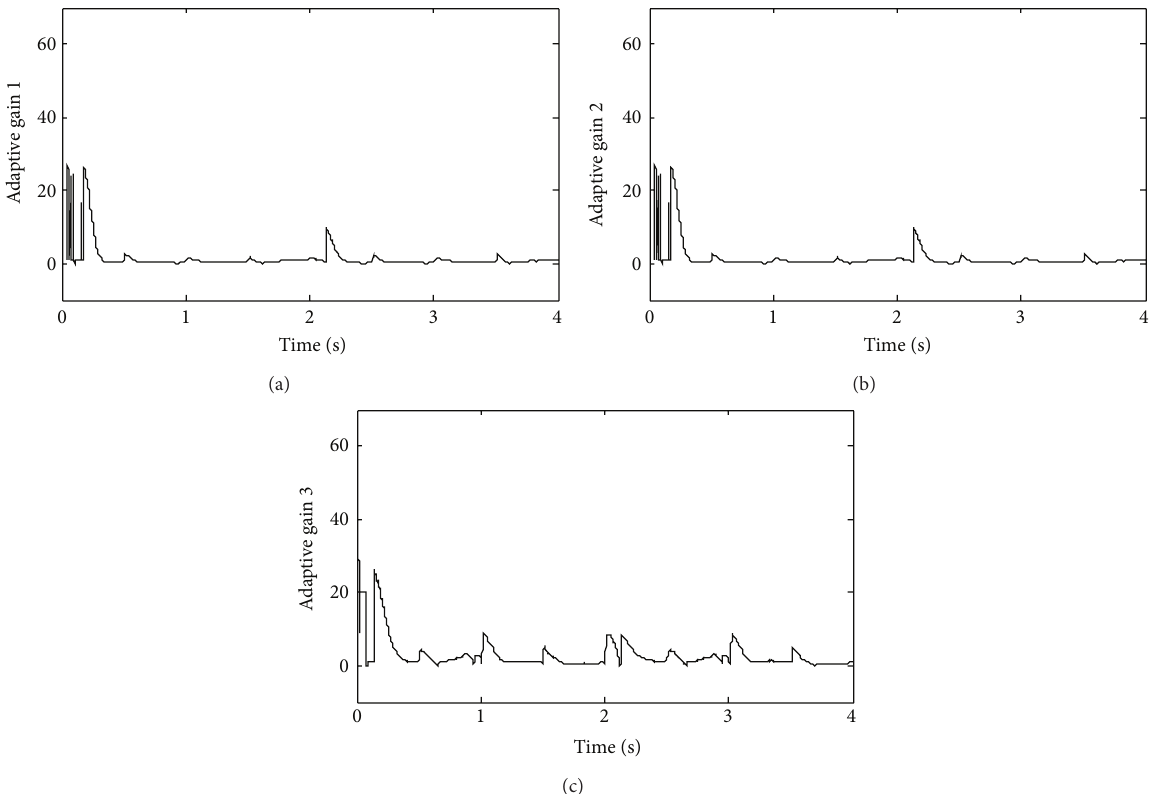
Figure 8: (a) The variety of self-turning gains 𝜆 1 , (b) the variety of self-turning gains 𝜆 2 , and (c) the variety of self-turning gains 𝜆 3